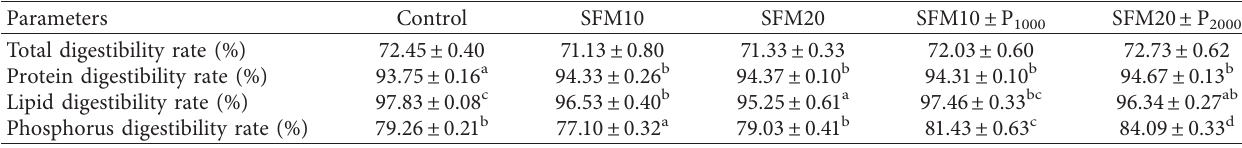
Table 4: Parameters related to feed digestibility rates of fish in the experiment.